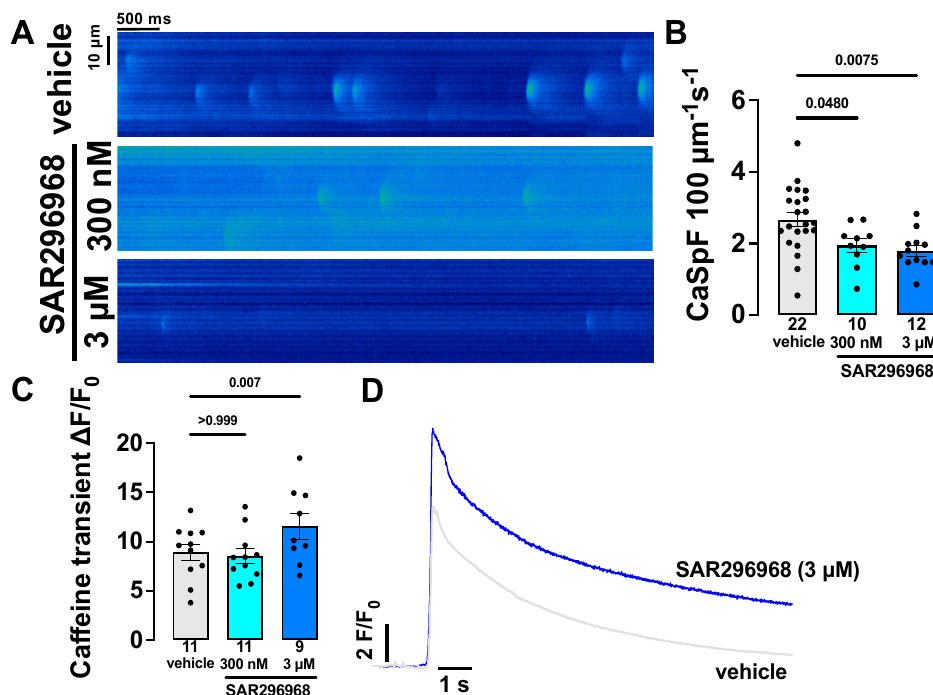
Figure 1. Ca 2+ sparks measurements in isolated human atrial myocytes. The numbers indicated are numbers of patients. The data points represent individual patients. Each data point was calculated as a mean from several cells within each patient. Ca 2+ spark frequency is reduced by SAR296968, original line scans are shown in ( A ), and mean data in ( B ). Fluo-4 transient amplitude after rapid caffeine application is shown in ( C ), the transient amplitude is significantly increased at 3 µ M, original caffeine transients in ( D ). The p -values are denoted above the corresponding groups, RM-mixed effects analysis with Bonferroni post-hoc